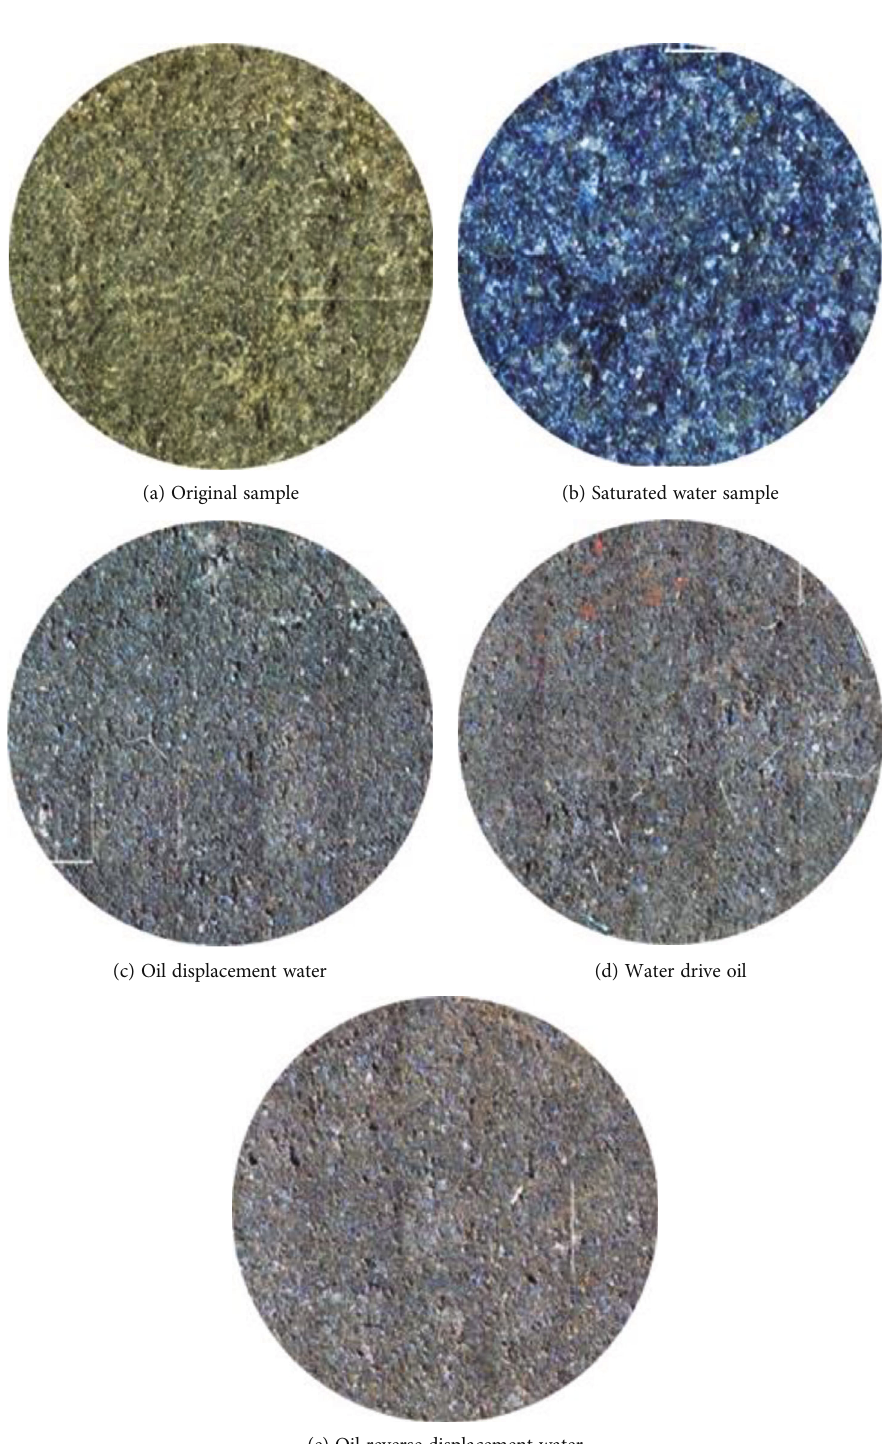
Figure 4: Photographic images for the stereoscopic microscope of di ff erent stages of core slice